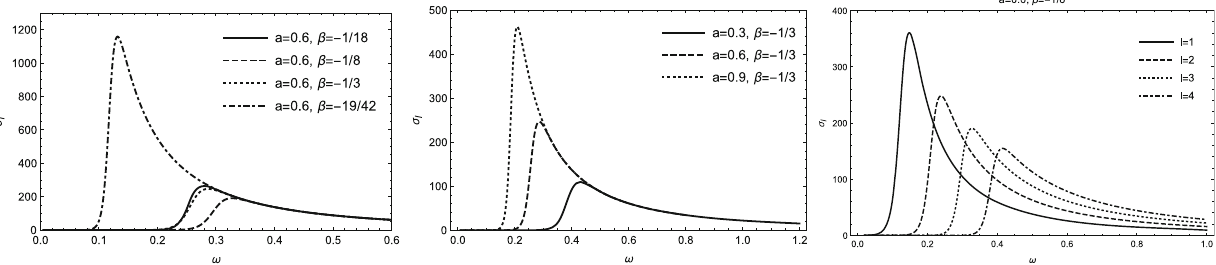
Fig. 6 For β > 0 and M = 1, the partial absorption cross section for the variable a at β = 1 a = 0 . 1, l = 3 in the center panel. The right plot is that the partial absorption cross section change with the multipole number l at a = 0 . 1 ,β = 1